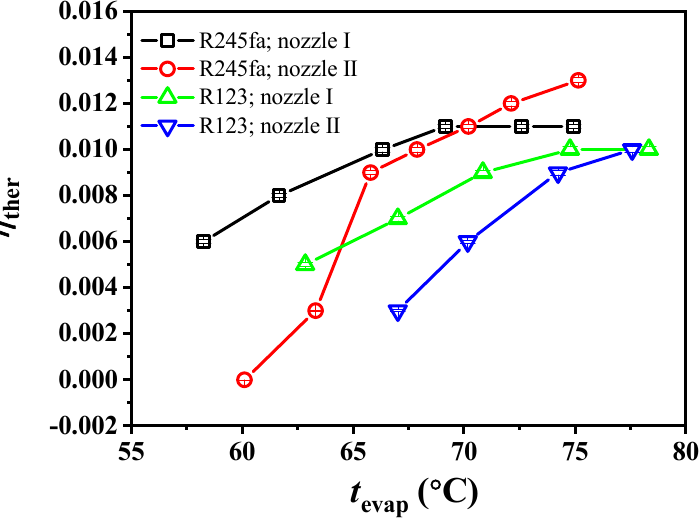
Figure 8. Variation of thermal efficiency with evaporating temperature.